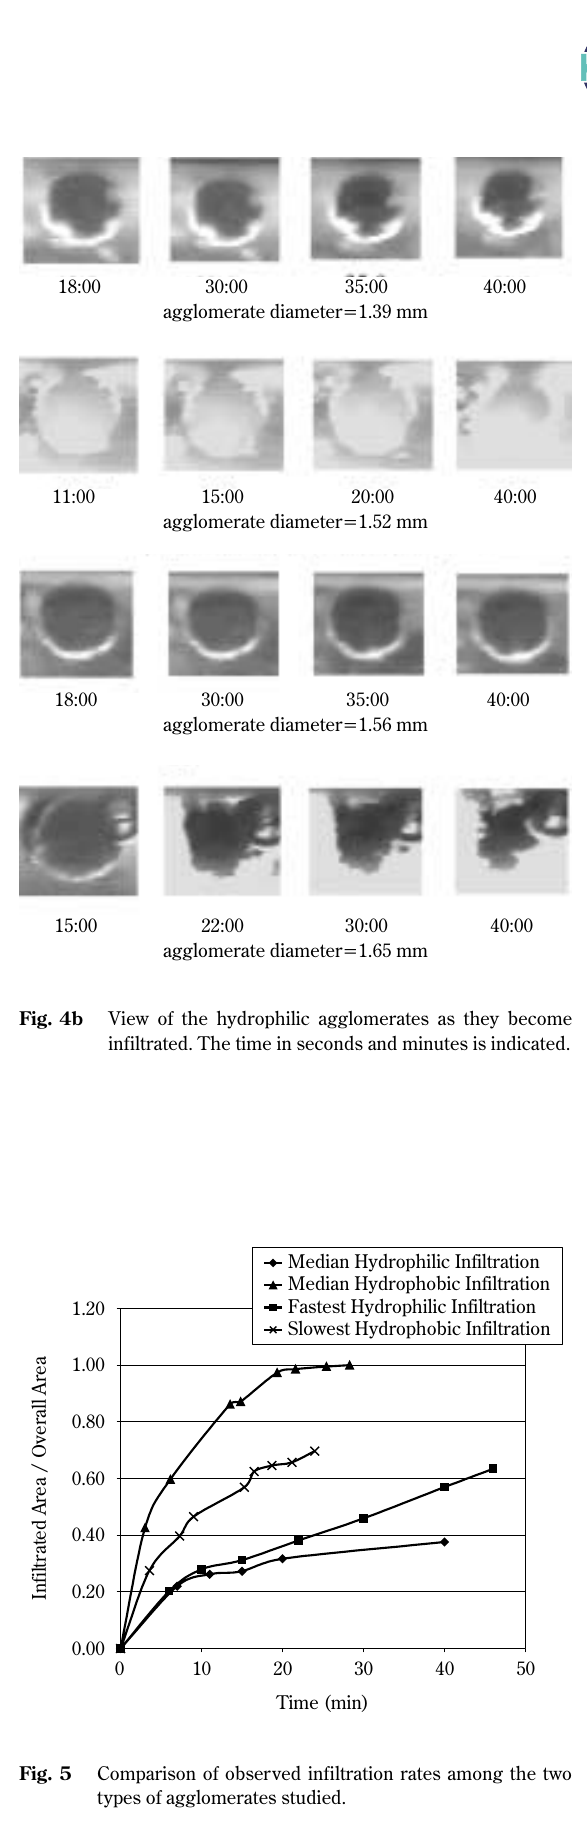
Fig. 5 Comparison of observed infiltration rates among the two types of